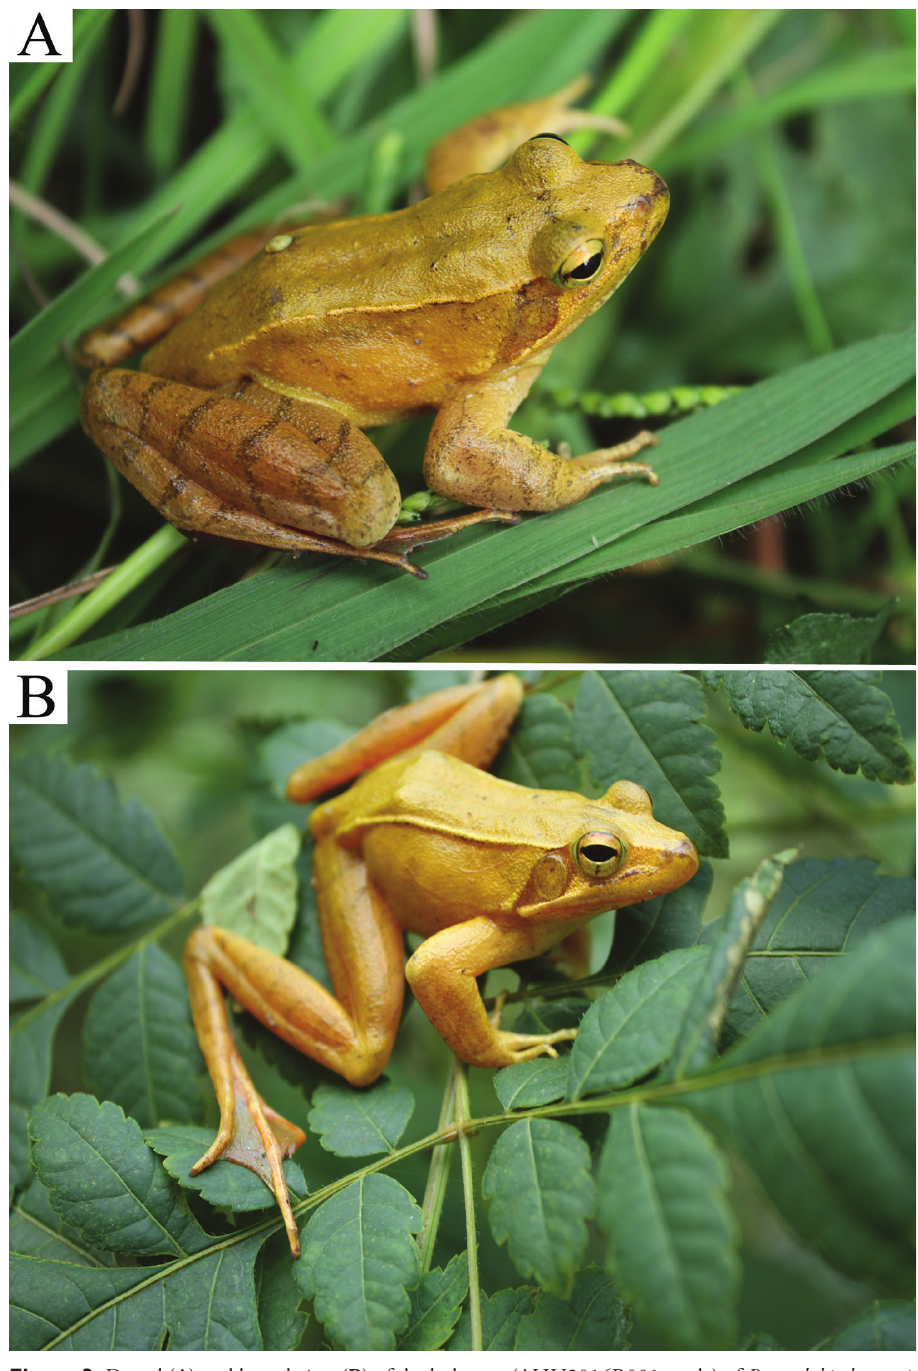
Figure 3. Dorsal ( A ) and lateral view ( B ) of the holotype (AHU2016R001, male) of Rana dabieshanensis sp. n. in